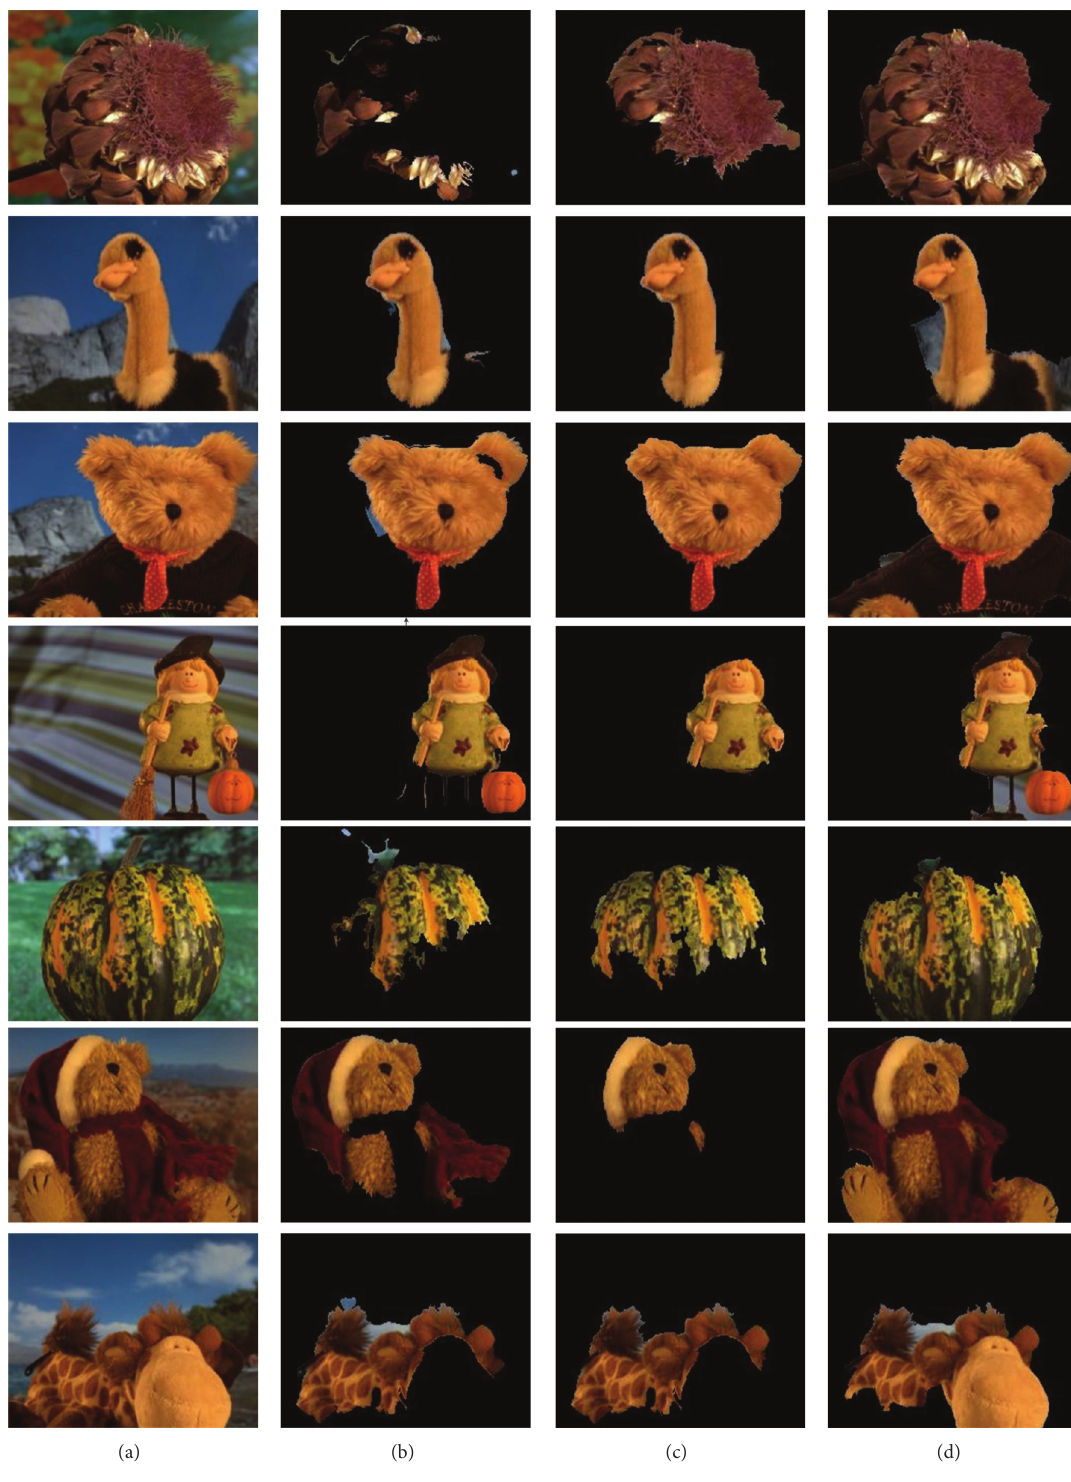
Figure 3: Results in the first data set. (a) Original images. (b) Foreground extracted with RC [13]. (c) Foreground extracted with TSS [14]. (d) Foreground extracted with